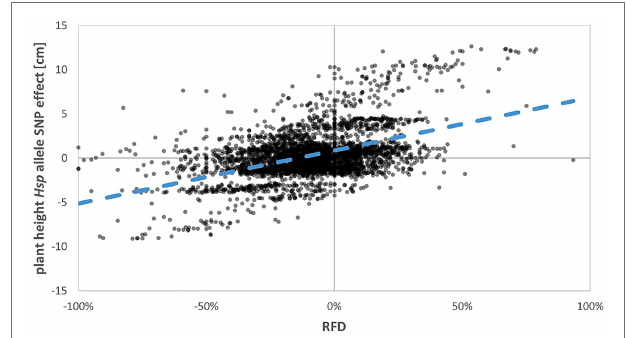
FIGURE 4 | Regression of estimated Hsp allele SNP effect for plant height on RFD. The Pearson correlation coefficient ( r ) is 0.48. The blue dashed line indicates the linear regression